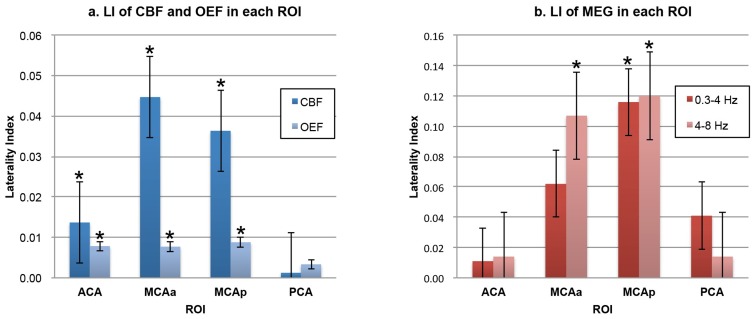
Bar graphs showing the LI of 15O-PET and MEG.The 15O-PET results showed statistically significant lateralities in CBF and OEF in the ROIs of the ACA, MCAa, and MCAp (a). The MEG results showed statistically significant lateralities for 4- to 8-Hz waves in the MCAa, and for 0.3- to 4-Hz and 4- to 8-Hz waves in the MCAp (b). Data are expressed as the mean ± standard error of the mean (n = 37). Significant laterality was determined with the 95% CI with the Bootstrap method [35]. (*: Range of 95% CI represents a positive value.)